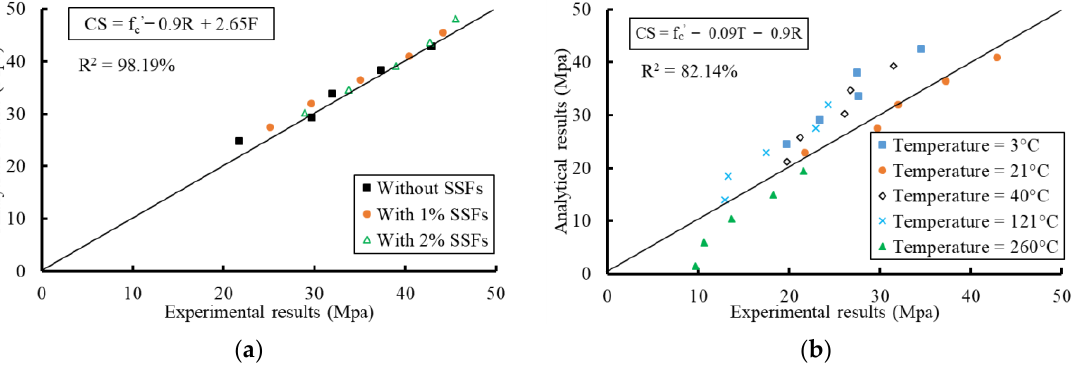
Figure 21. Regression between the analytical and experimental values of compressive strength. ( a ) The effect of CR content. ( b ) The effect of CR content and temperature.